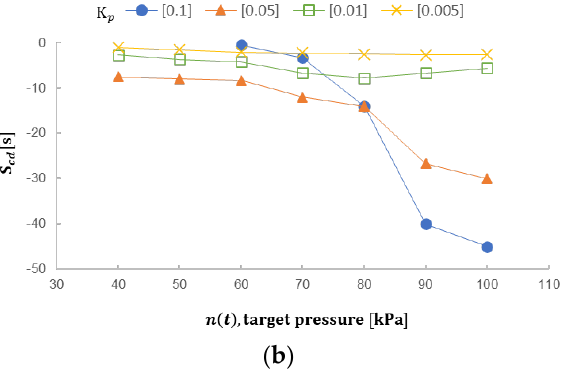
Figure 8. When K p = 0.1, 0.05, 0.01, and 0.005, ( a ) The different n ( t ) values and the corresponding convergence time T c and ( b ) The different n ( t ) values and the corresponding convergence decline slope S cd .